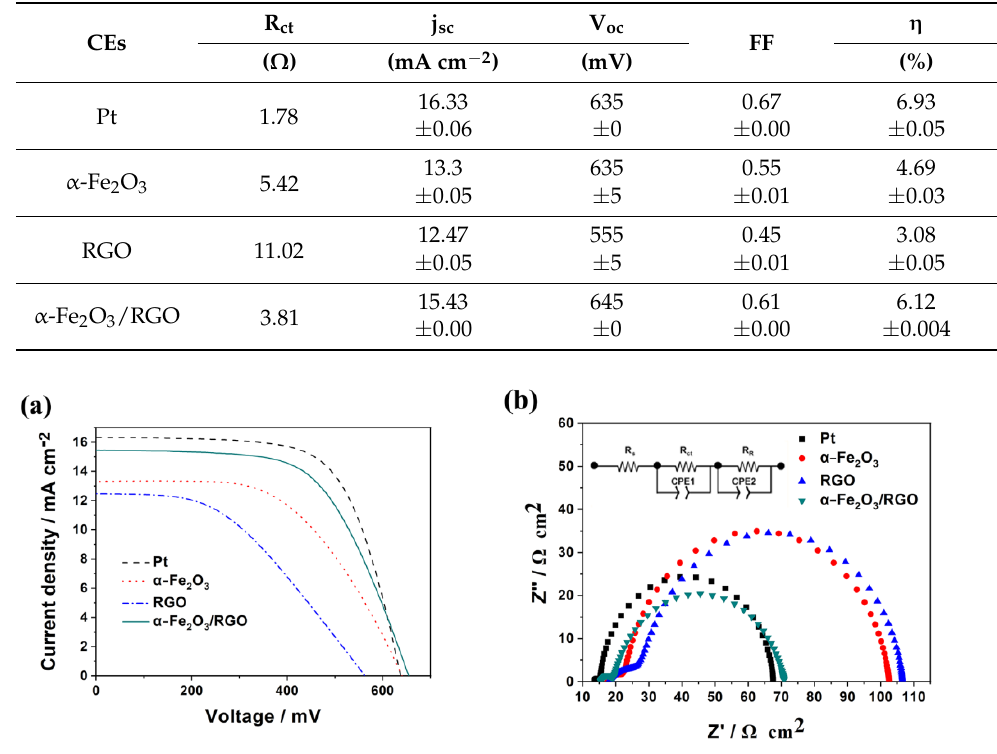
Table 1. PCE performances and EIS parameters of the DSSCs with different CEs.